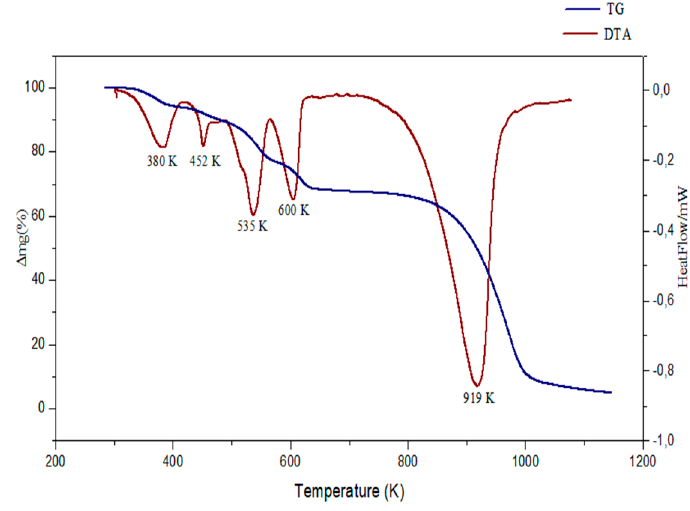
Figure 16. TGA/DTA curves of (C 6 H 8 Cl 2 N 2 ) 2 [Cd 3 Cl 10 ]·6H 2 O.